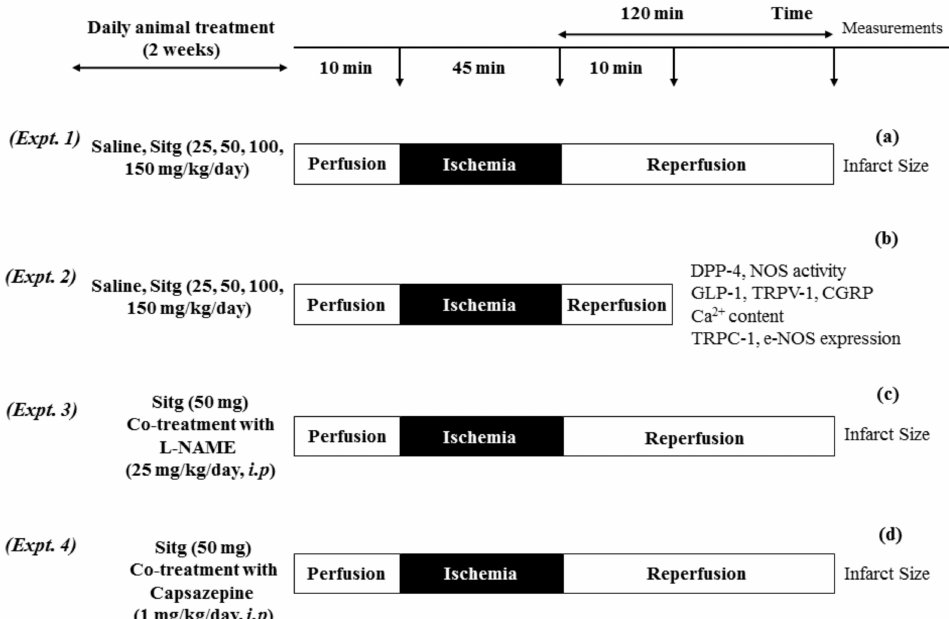
Figure 12. Diagram illustrating 4 different I/R experimental protocols. ( a ) Heart tissues subjected to 45 min ischemia and 120 min of reperfusion, after 2 weeks of oral animal treatment with Saline and different doses of Sitagliptin, for infarct size measurement. ( b ) Hearts subjected to 45 min ischemia and 10 min brief reperfusion, after which the animals received a 2 weeks’ oral administration of Saline and Sitg (50 mg), for further biochemical measurements. Infarct size measurement from heart tissues exposed to prolonged ischemia-reperfusion injury, after which the animals received a 2 weeks’ co-treatment of Saline, Sitg (50 mg) and intraperitoneal injection of NOS-inhibitor ( L -NAME) ( c ). In the 4th experimental protocol ( d ), the inhibitory effect of TRPV-1 against ischemia-reperfusion (IR) injury was assessed by heart infarct size measurement at the end of a prolonged reperfusion-injury, and after co-treating the animals intraperitoneally with Capsazepine (TRPV-1 inhibitor).